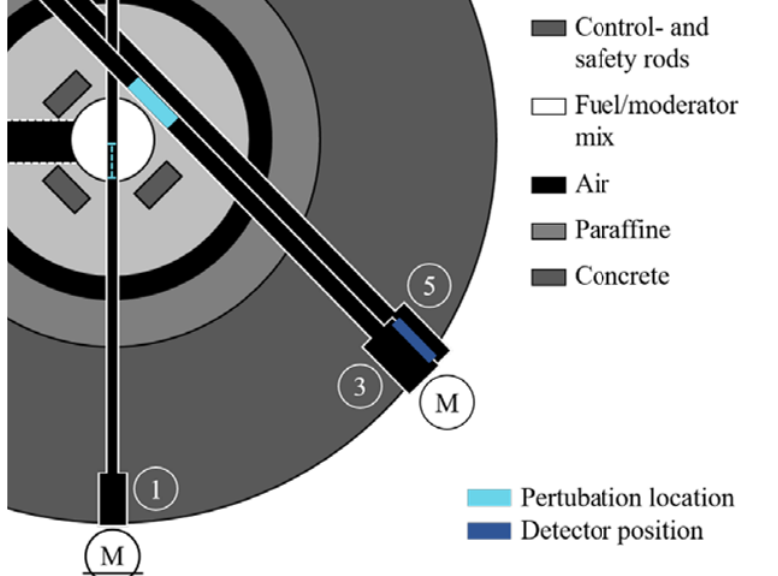
Figure 4. Partial cross section of the AKR-2 with the experimental setup: Cross section mesh-up of three cross sections of the AKR-2 (-8 cm, 0 cm, +8 cm in vertical direction, regarding the core center). The experimental channels 1, 3, 5 can be seen as well as the location of the detector (dark blue) and the perturbation locations (light blue). The vibrating absorber is located in channel 1, the absorber of variable strength in channel 3 and the detector in channel